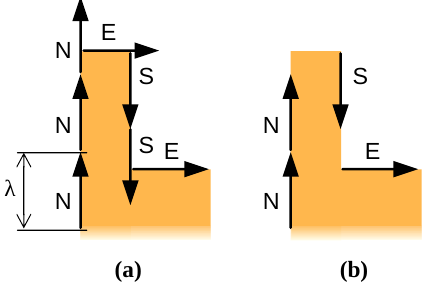
Figure 6. Two possible approaches to encoding polygon edges whose lengths are not a multiple of the symbol length λ : ( a ) edges (and edge fragments) shorter than λ are encoded as symbols; ( b ) such edges are